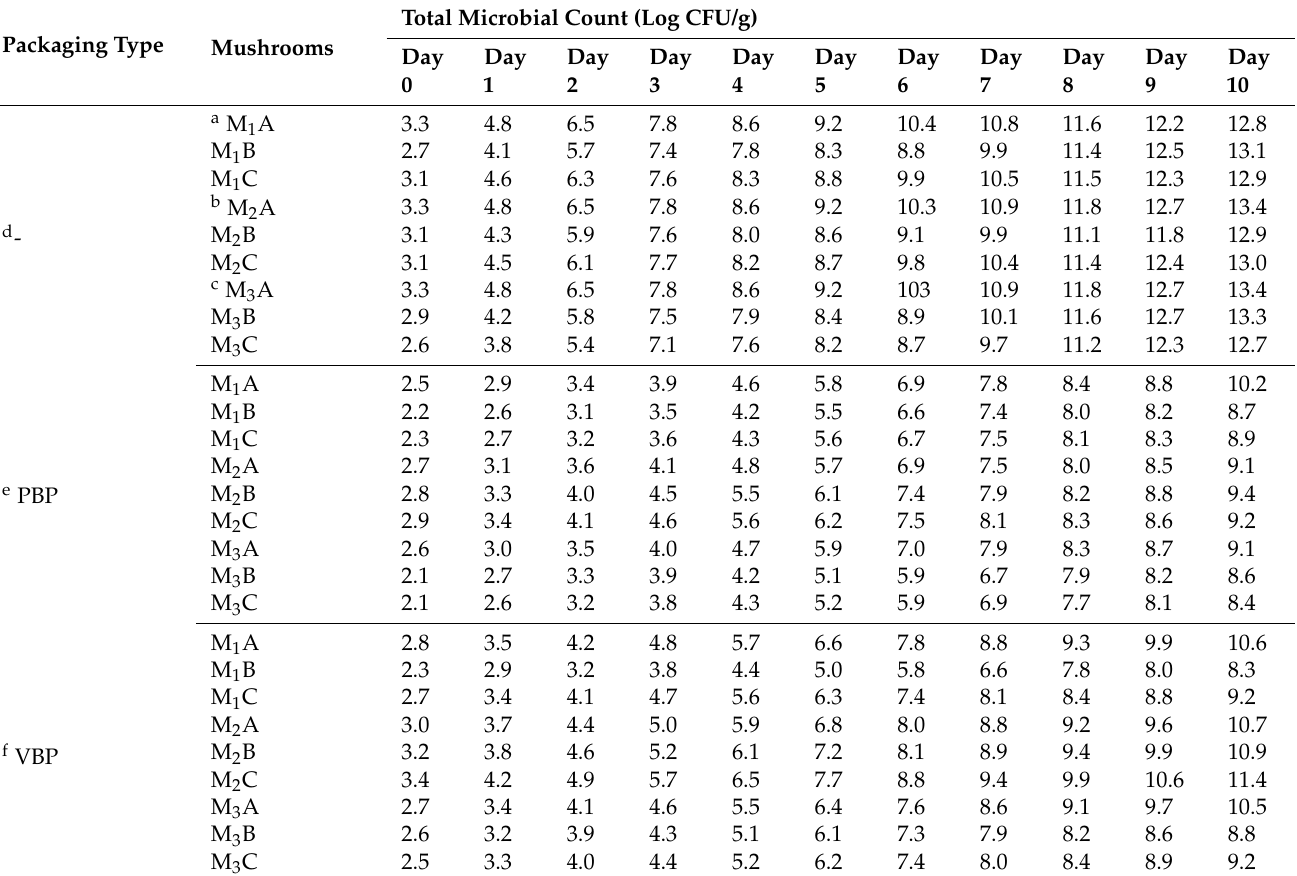
Table 8. Total microbial count on mushrooms stored at ambient temperature (log CFU/g).